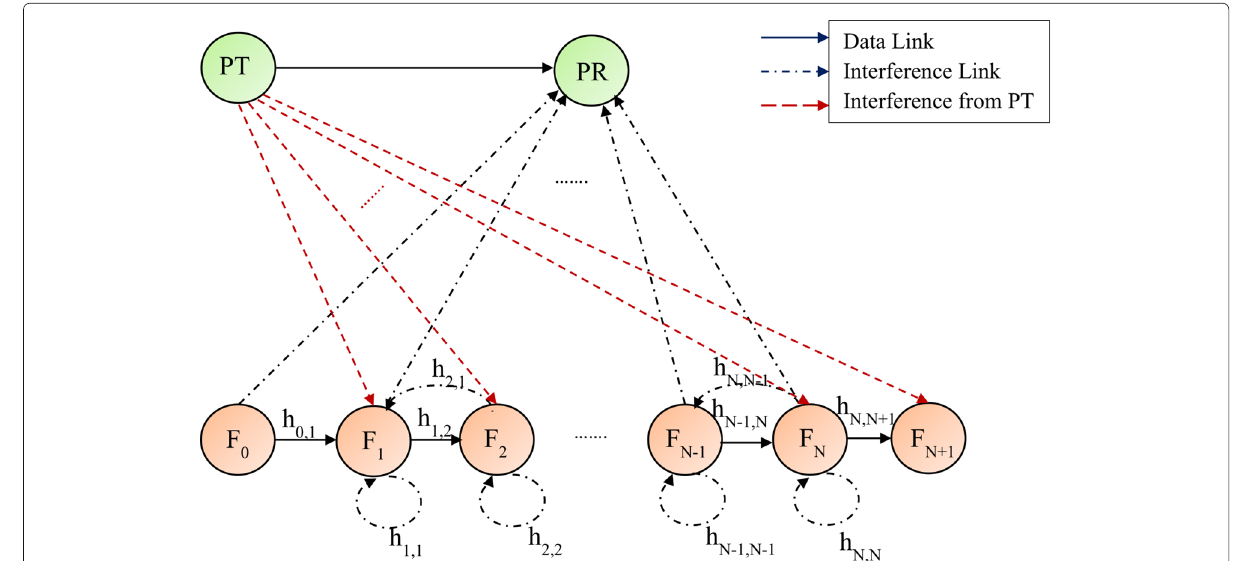
Fig. 1 Multi-hop cognitive